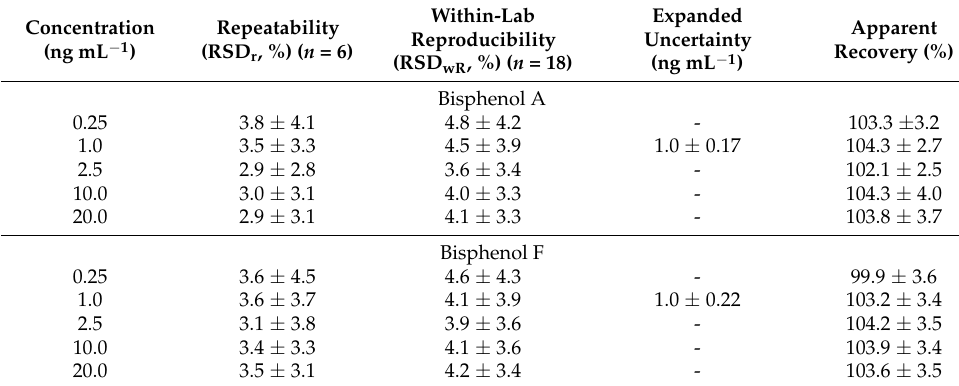
RSD r —relative standard deviation for repeatability; RSD wR —relative standard deviation for with-